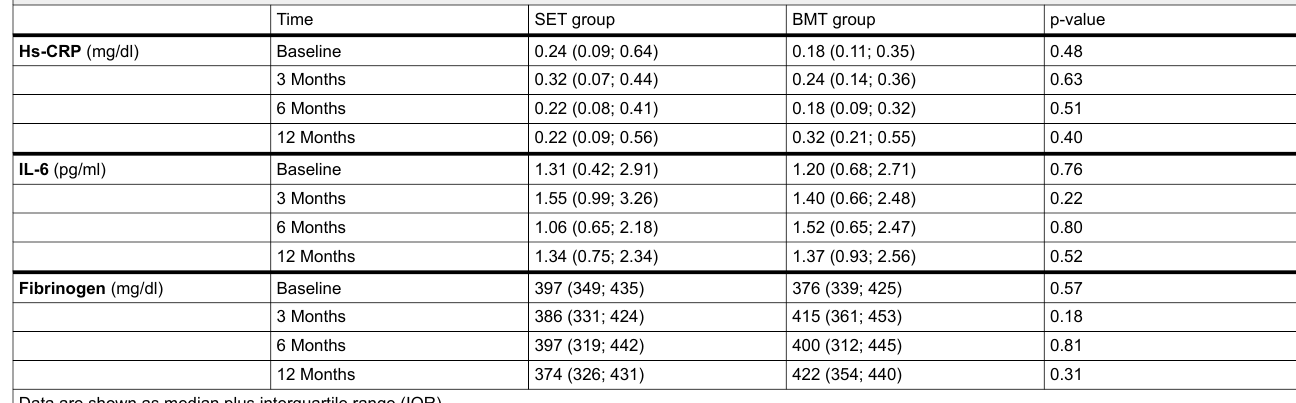
Table 2: Inflammatory markers of 27 patients receiving supervised exercise training (SET) versus 26 patients receiving BMT